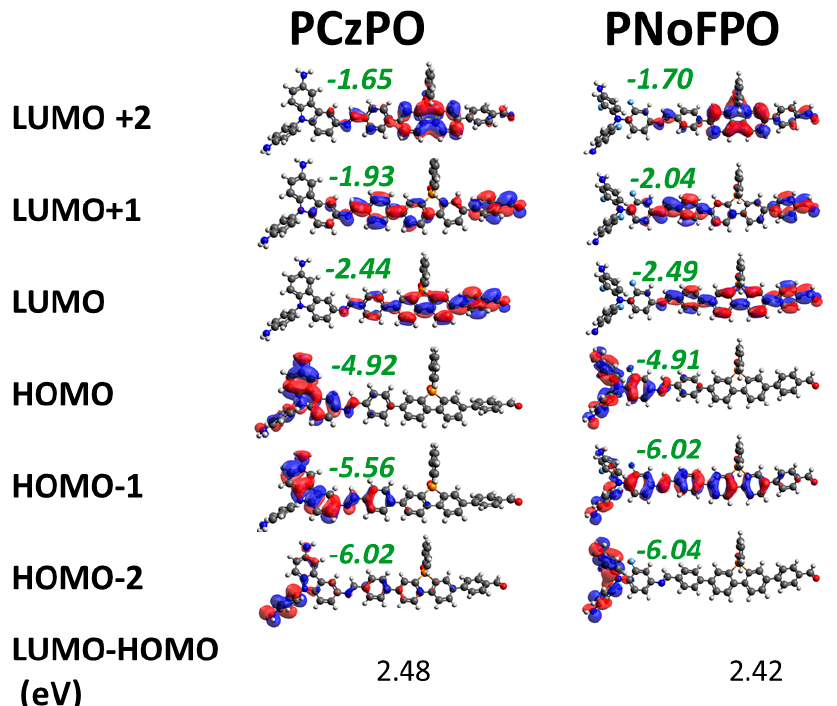
Figure 2. 3D electron density distribution of the frontier orbitals of PCzPO and PNoFPO D-A moieties, computed at the B3LYP/6-311G(d,p) level of theory. Energy levels (eV) of each orbital is shown in green, and the HOMO-LUMO gaps are shown at the bottom of each column.